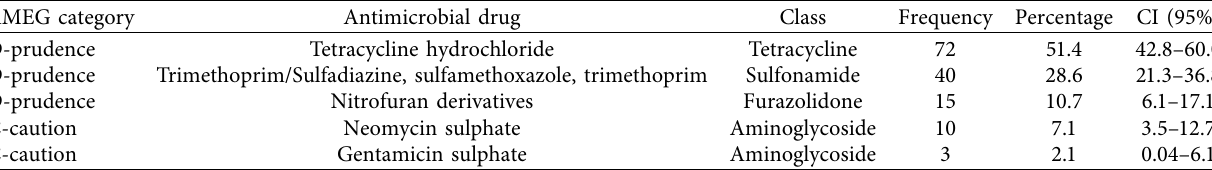
Table 3: AMEG categories of veterinary antibiotics used in poultry production in Masindi district.